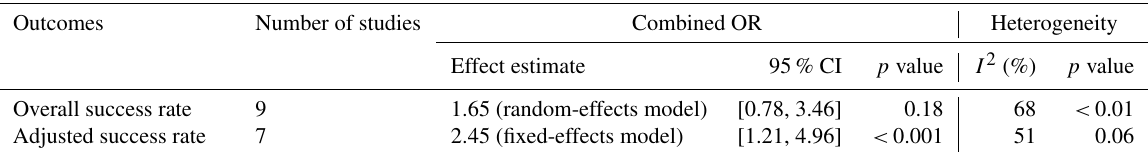
Table 4. Success rate outcomes among heterogeneous and homogeneous populations. Outcomes